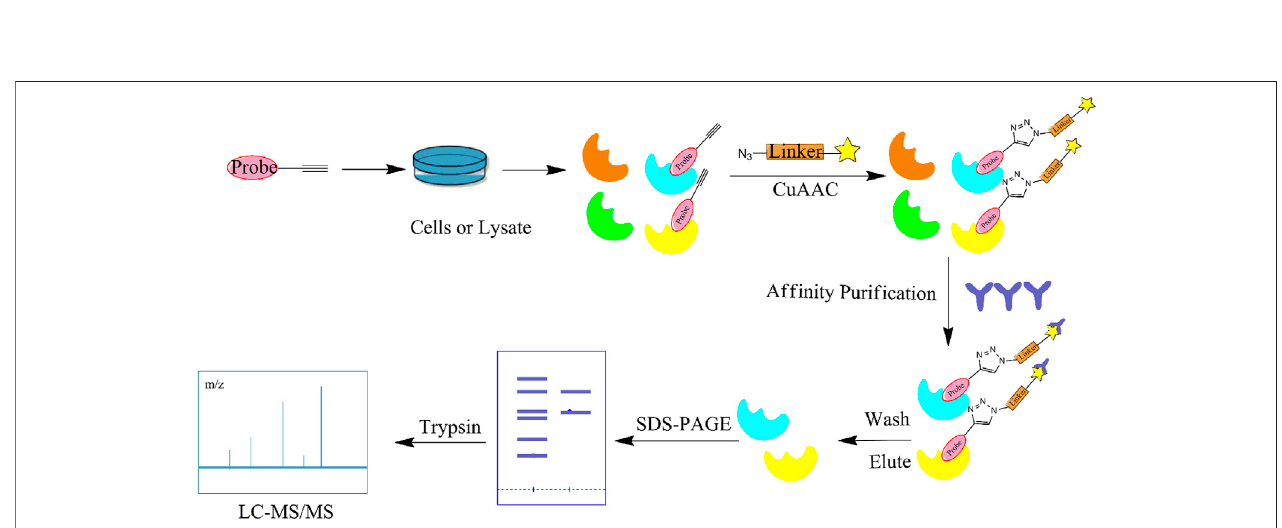
FIGURE4| Flowdiagram oftheclickchemistry – activity-basedprotein pro fi ling(CC-ABPP)strategy.Itstartswiththesynthesis ofaNPwithaterminalalkyne.After suf fi cientbindingtothetargetprotein,theprobeisformedbyaclickreactionwithanazidebearinga fl uorescentorradioactivemoiety.Thetargetproteinissubsequently identi fi ed by SDS-PAGE and